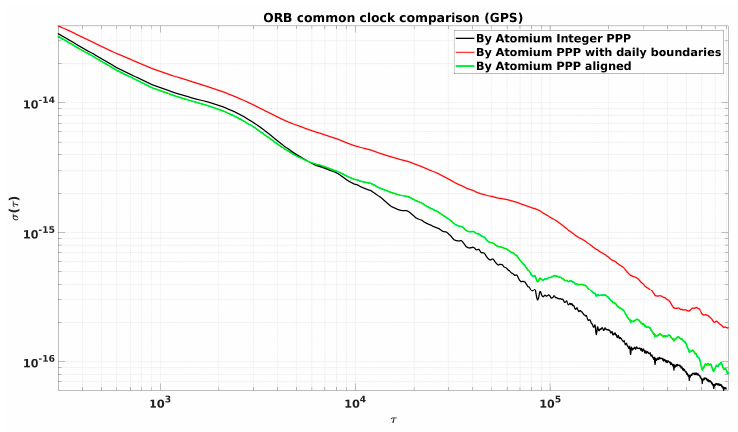
Figure 17. ADEVs between integer PPP and PPP CCD results in ORB.